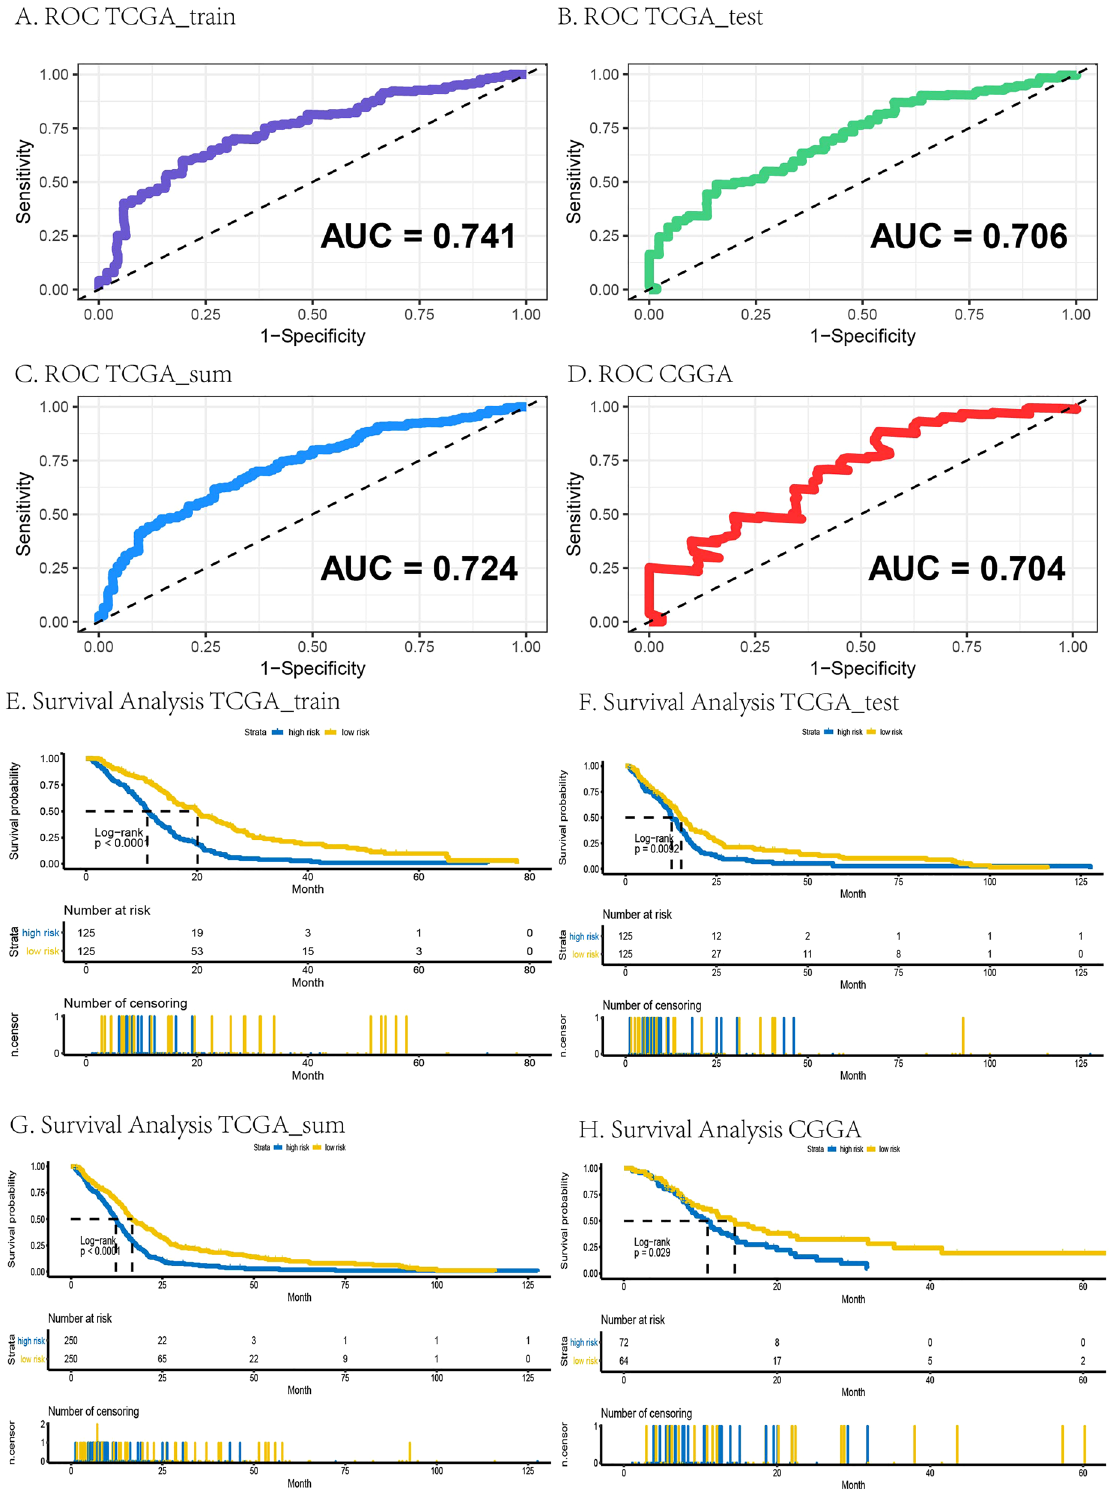
Figure 3. Verification of the prognostic risk score model based on a hypoxic 7-gene signature in GBM. ( A–D ) ROC curves in TCGA (train set, test set, sum set) and CGGA, respectively. ( E – H ) K–M survival curves in TCGA (train set, test set, sum set) and CGGA, respectively. The p values were shown in the plot